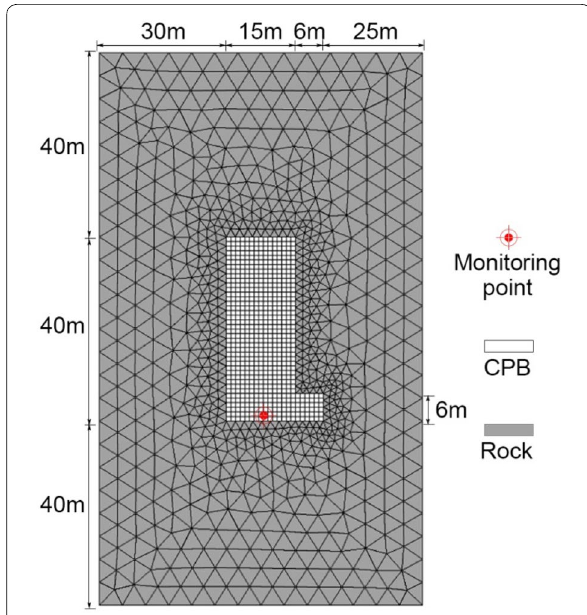
Fig. 7 Mesh and geometry of simulated stope at Kanowna Belle mine